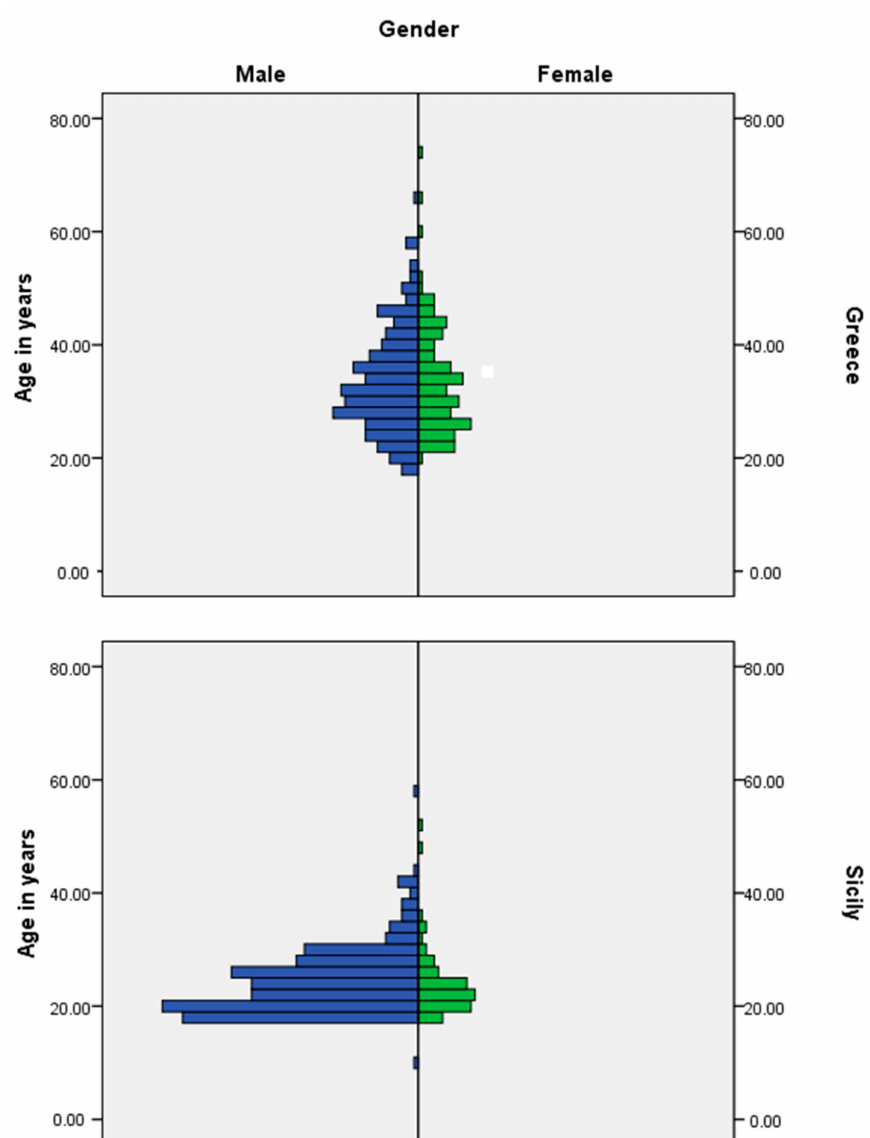
Figure 3. Participants by country of arrival, gender, age and